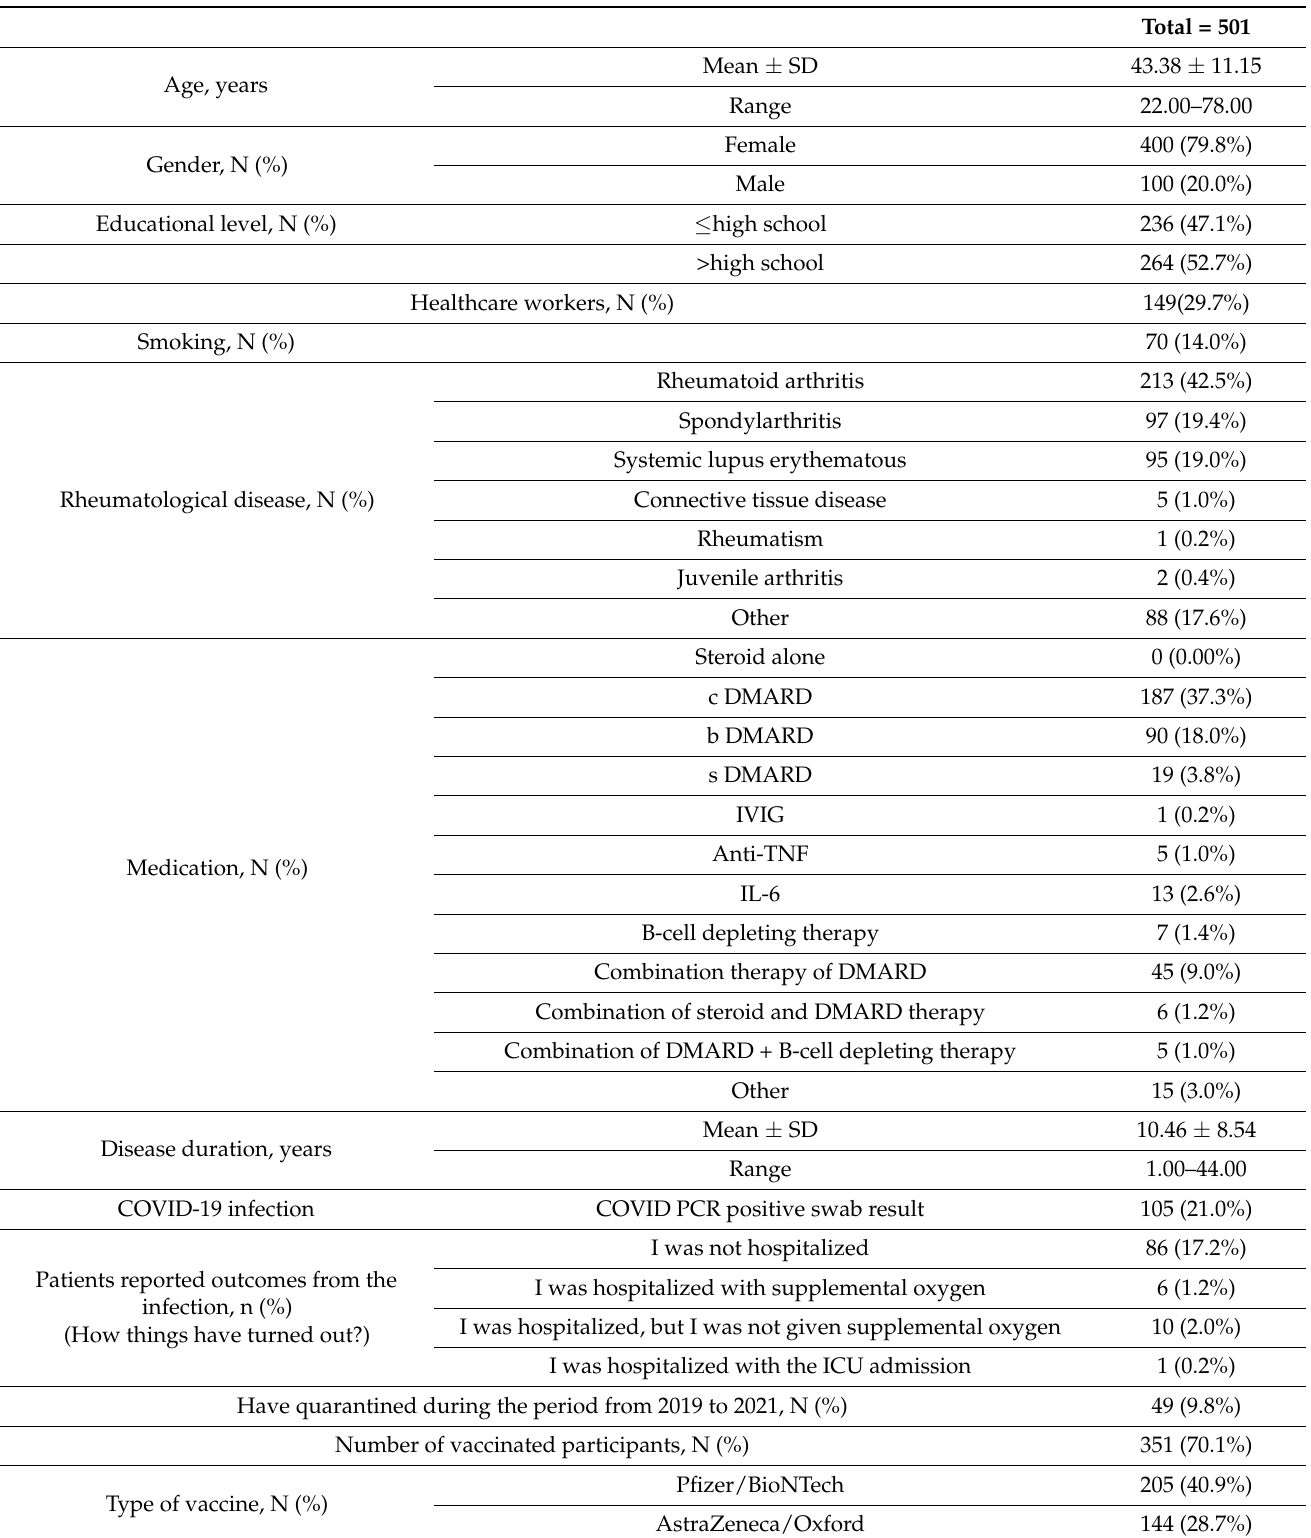
Table 1. Demographic characteristics of the included